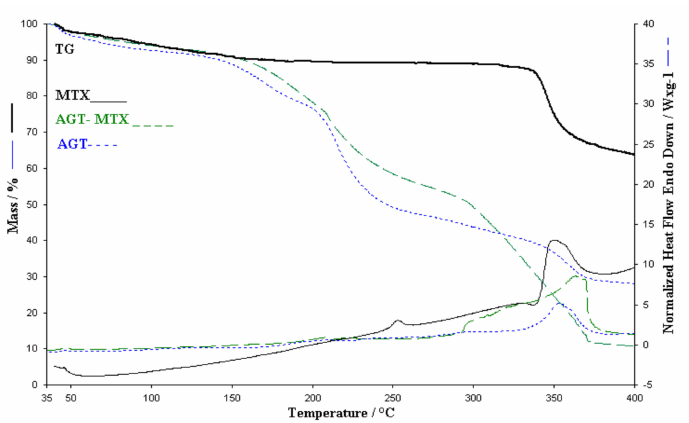
Figure 9. Comparative of TGA and HF for AGT membrane, AGT-MTX and